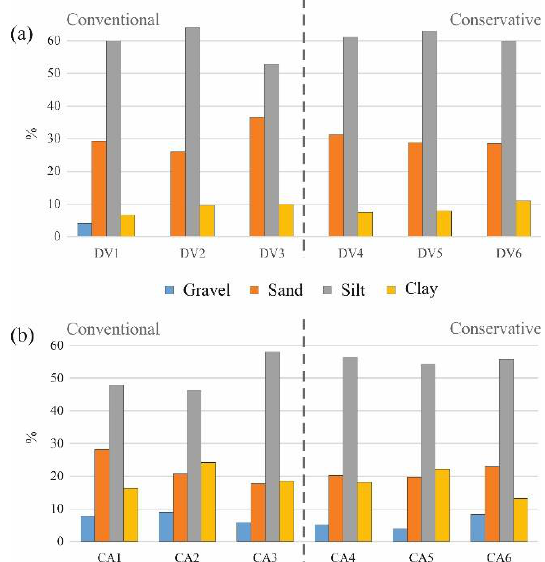
Figure 8. Distribution of grain size fractions in the samples collected in the study sites. ( a ) DV field in a soil developed above the Olocene terraced alluvial sediments of the Ofanto River. ( b ) CA field in a soil formed on the Pleistocene terraced deposits, mainly consisting of polygenic conglomerates locally embedded with sandy levels.